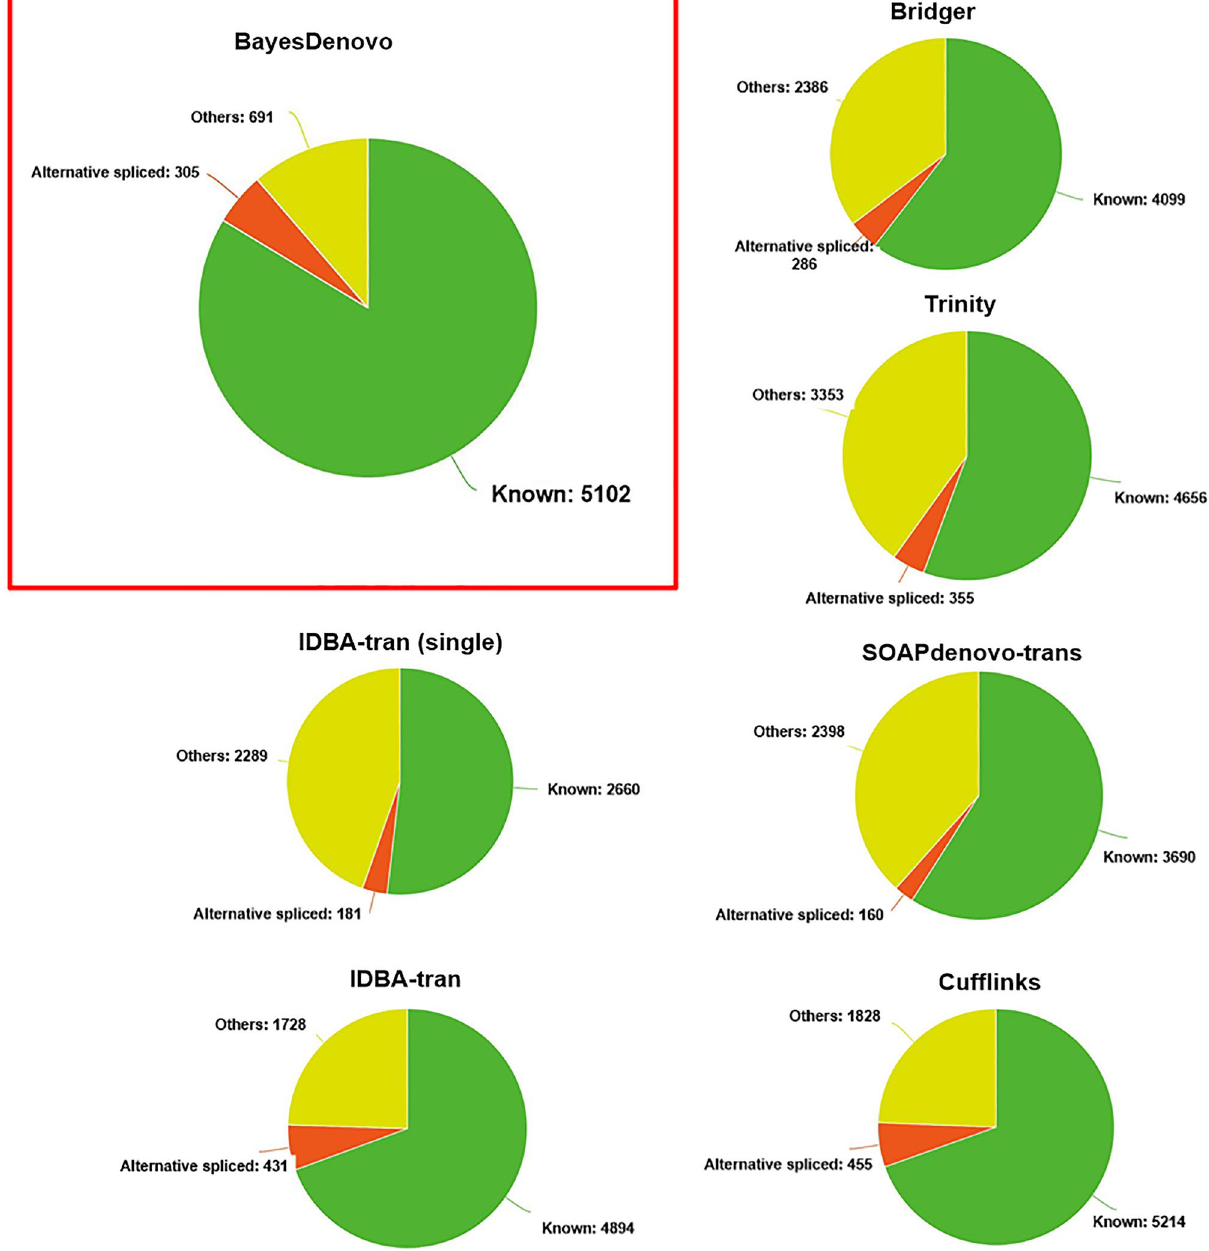
Figure 2. Transcripts assembled by competing methods that are common to the three cell line replicates in the